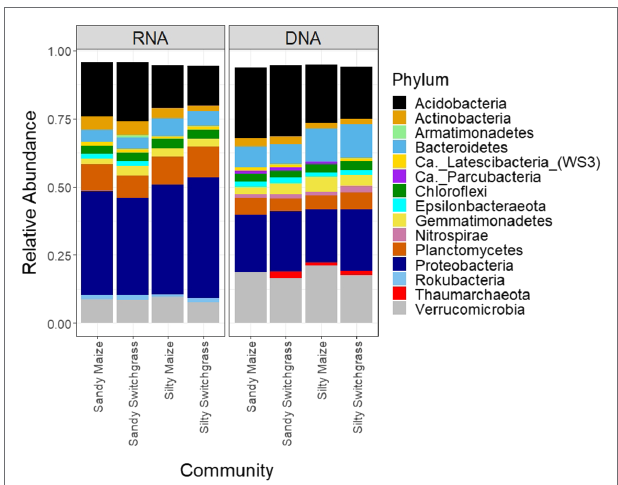
FIGURE 4 | Relative abundance of bacterial and archaeal phyla separated by site/crop combination based on sequencing of 16S rRNA gene fragments at the DNA and RNA level ( n =